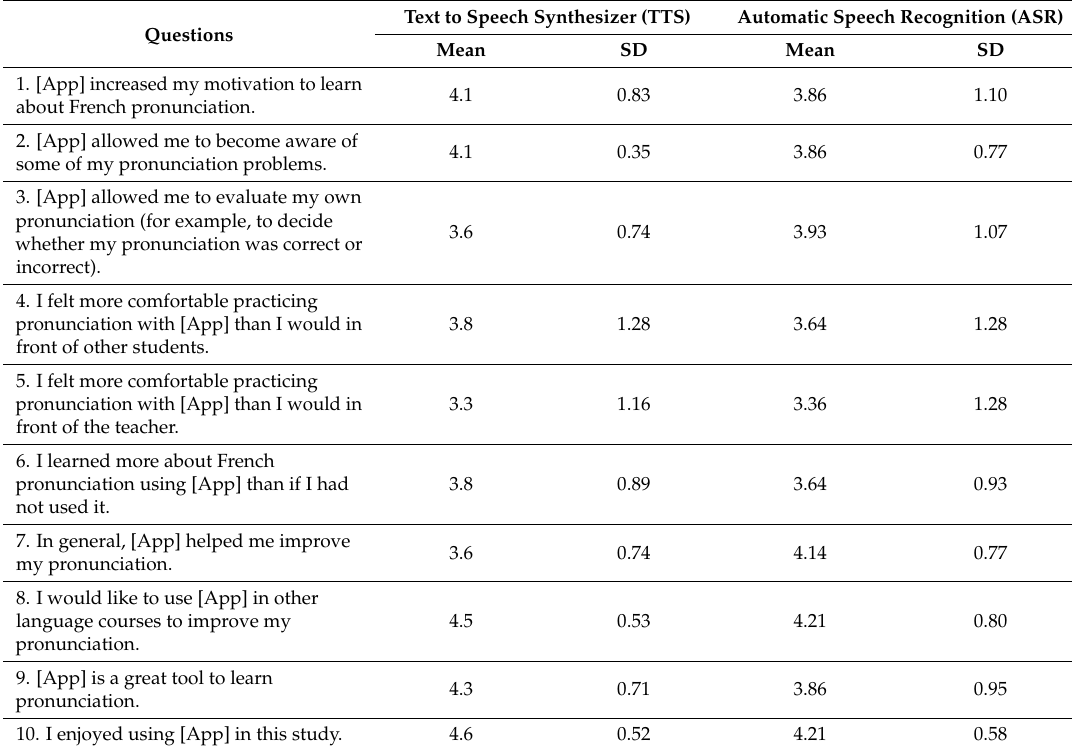
Table 1. Survey results: Learners’ perception of mobile TTS and ASR ([App] refers to the respective app used: TTS or